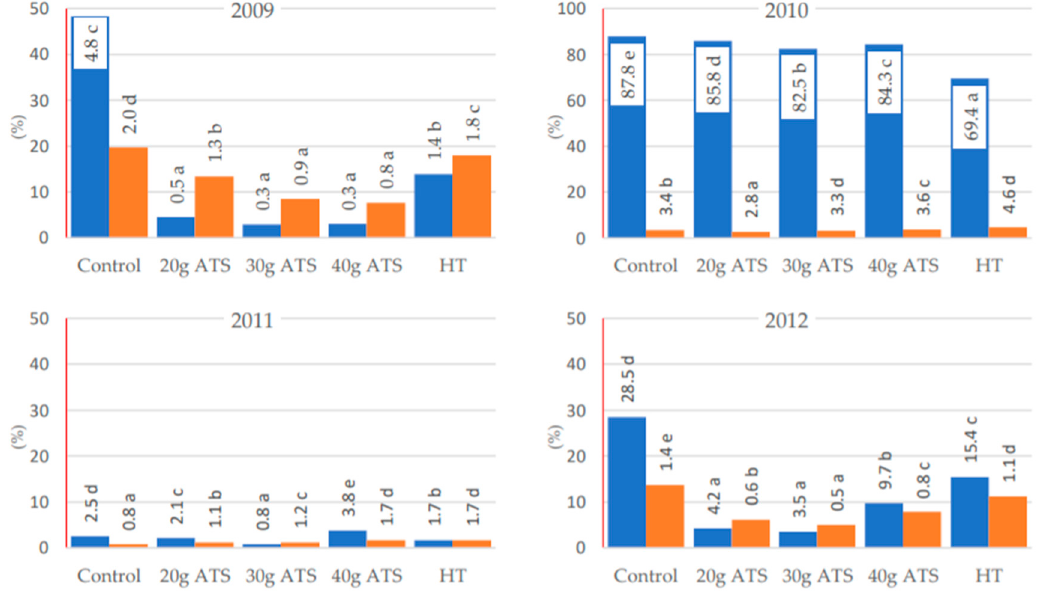
Figure 4. The effect of thinning on fruit set and fruit drop of Regina sweet cherry trees in 2009–2012. 1 one-way analyses of variance; data in bars of the same colour, marked with the same letter, are not significantly different at α = 0.05 (Duncan’s test).